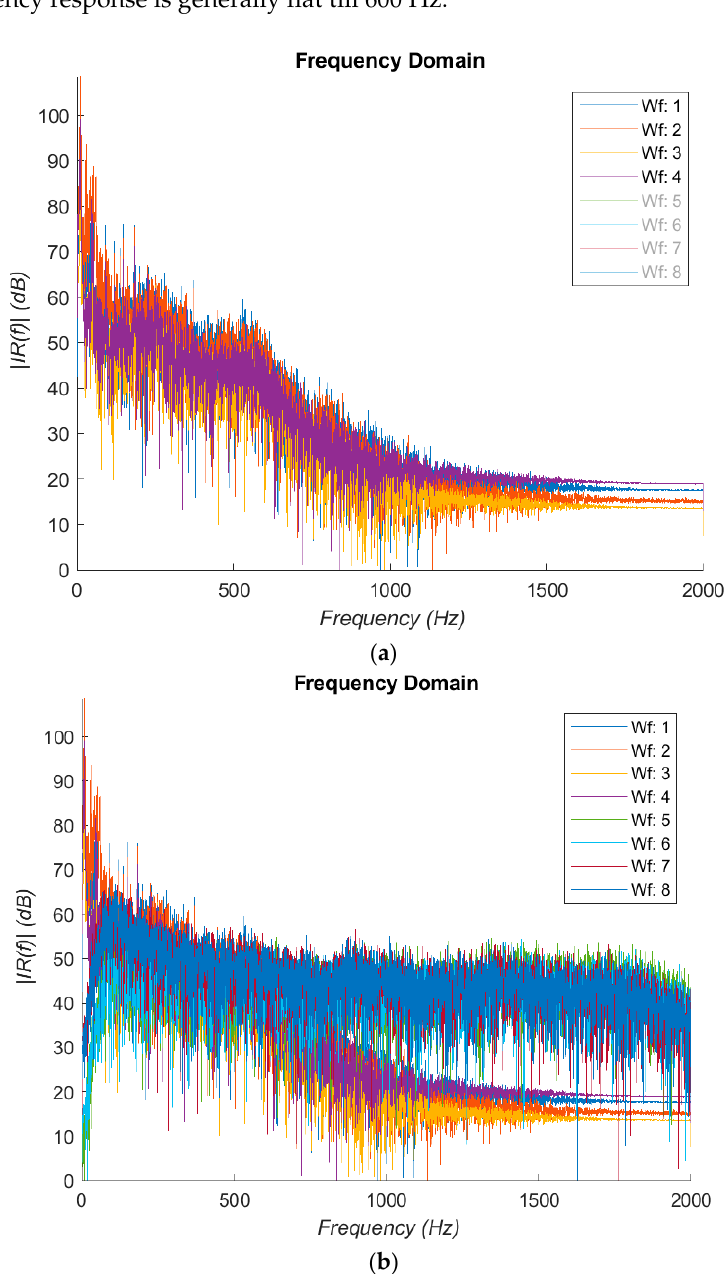
Figure 2. ( a ) Frequency response of stethoscope from a noise signal. ( b ) Overplayed stethoscope and accelerometer signals, Tracks 1–4: stethoscope; Tracks 5–8: accelerometer.